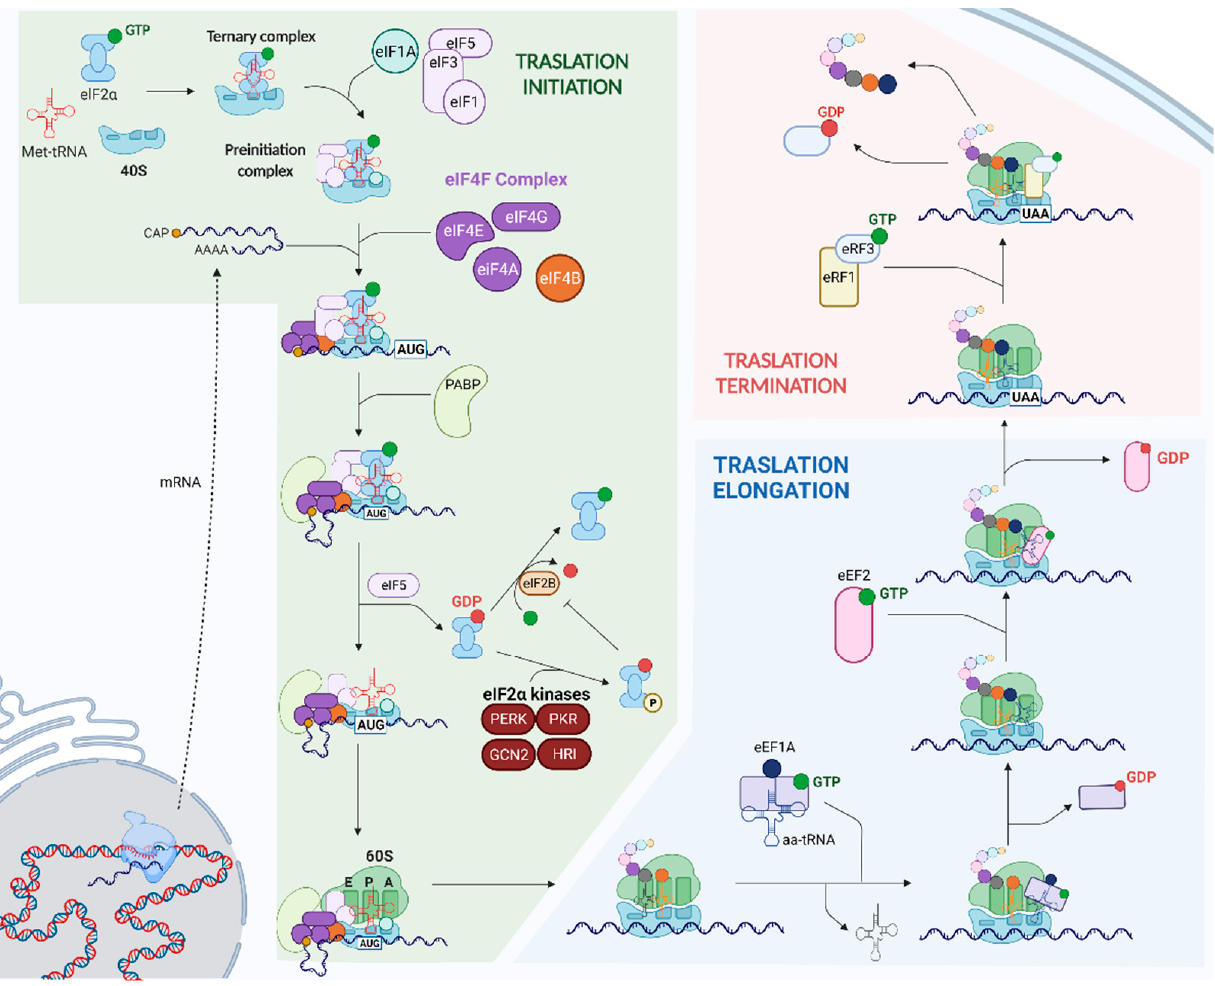
Figure 1. Assembly of the preinitiation complex (PIC), eIF4F complex (eIF4E, eIF4G, and eIF4A), and eIF4B in the 5 ′ cap of the mRNA triggers initiation (dashed arrow). Once a start codon (AUG) is found, eIF2-GDP is released, the 60S ribosomal subunit joins the PIC, and an elongation-competent 80S ribosome is formed. eIF2-GDP can undergo incapacitating phosphorylation that blocks protein synthesis under stress conditions. During elongation, the ternary complexes of eEF1A-GTP-aminoacyl-tRNA bind to the ribosome at the A site, increasing the length of the aminoacidic chain. Several rounds of elongation occur until a stop codon is reached, at which point the complex eRF1-eRF3-GTP recognizes it and translation is terminated.